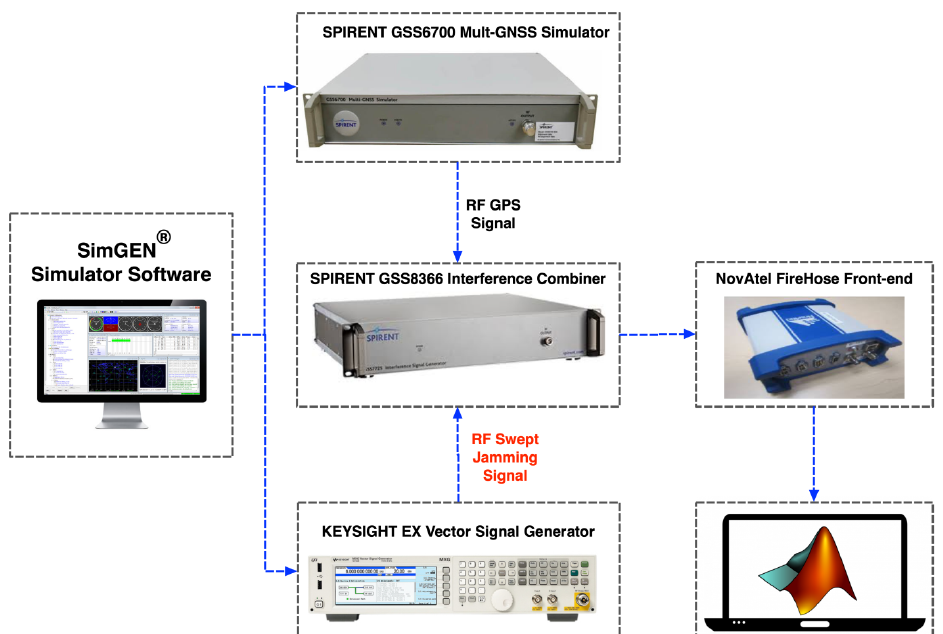
Figure 3. Block diagram of the experimental setup.